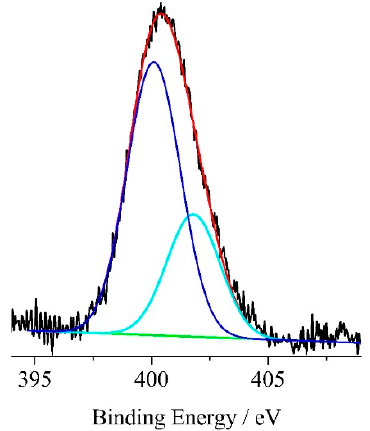
Figure 2. Al-K α excited XPS of CNPs-Naphthyl-Di-AE in the N 1s binding energy region. The blue and cyan lines refer to the 400.1 and 401.7 eV components; the green line refers to the background, and the red line superimposed to the experimental black profile refers to the sum of all Gaussian components.